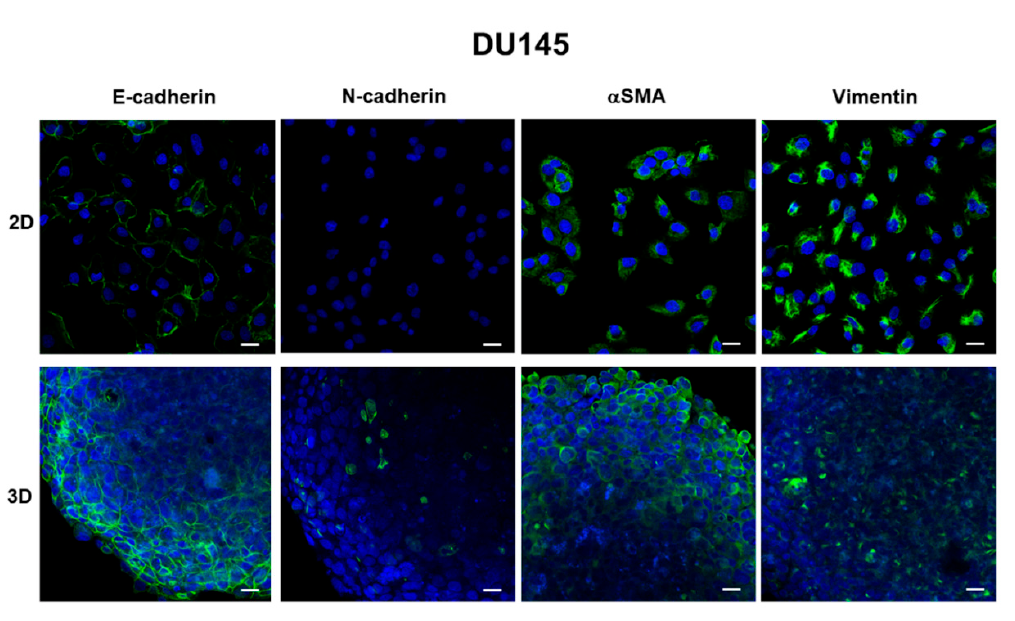
Figure 2. Immunofluorescence analysis of epithelial-to-mesenchymal (EMT) markers in DU145 cells. Micrographs using the confocal microscope showing the epithelial marker E-cadherin and mesenchymal markers N-cadherin, α SMA and vimentin (green) in DU145 cells grown in 2D-monolayers and in 3D-spheroids. Original magnification: 40 × . Bar: 20 µ m. Blue: DAPI.